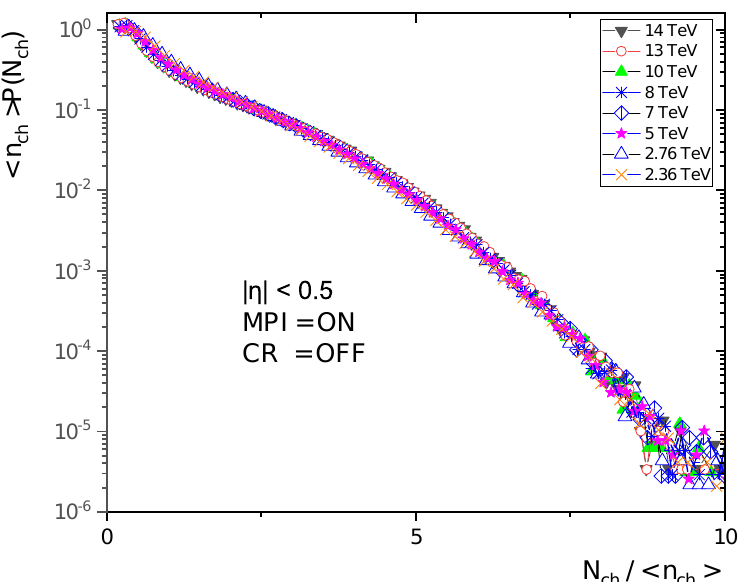
Figure 14. KNO form of charged particle multiplicity distribution at different energies in pseudora- pidity | η | < 0.5 with MPI = ON and CR = OFF.